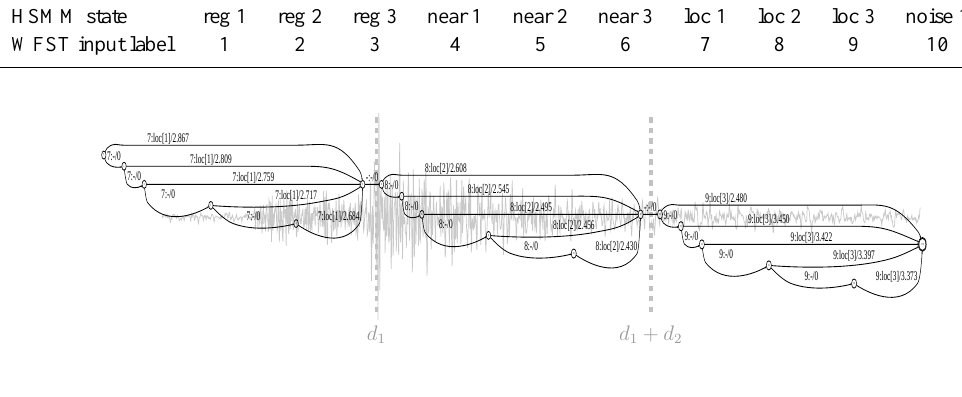
Fig. 6. Concatenated Weighted Finite-State Transducer. The WFST is the result of concatenating the WFST shown in Fig. 5 for the first, second and third loc state. The labeling of the above figure is described in Fig. 5. The corresponding mapping from HSMM states to WFST input labels is described in Table 1. Note that for visualization, only the first 5 paths per HSMM state are plotted.